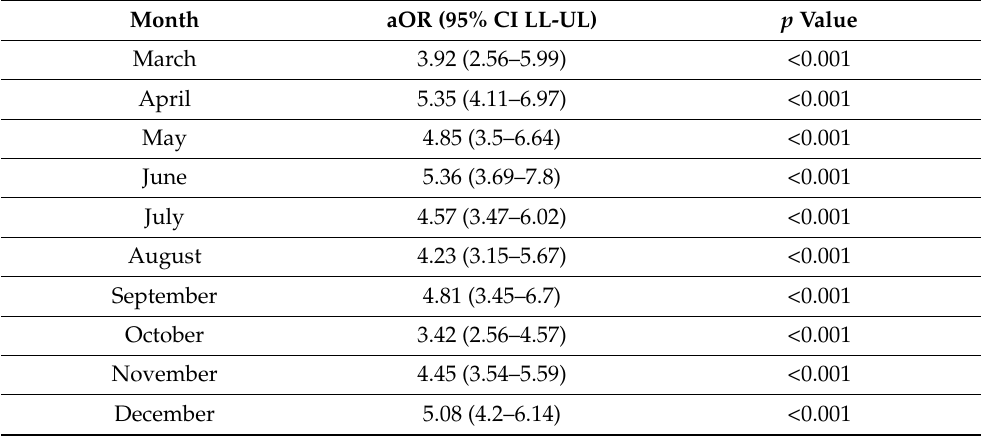
Table 3. Monthly In-Hospital Mortality Among NSTEMI Patients with COVID-19 During